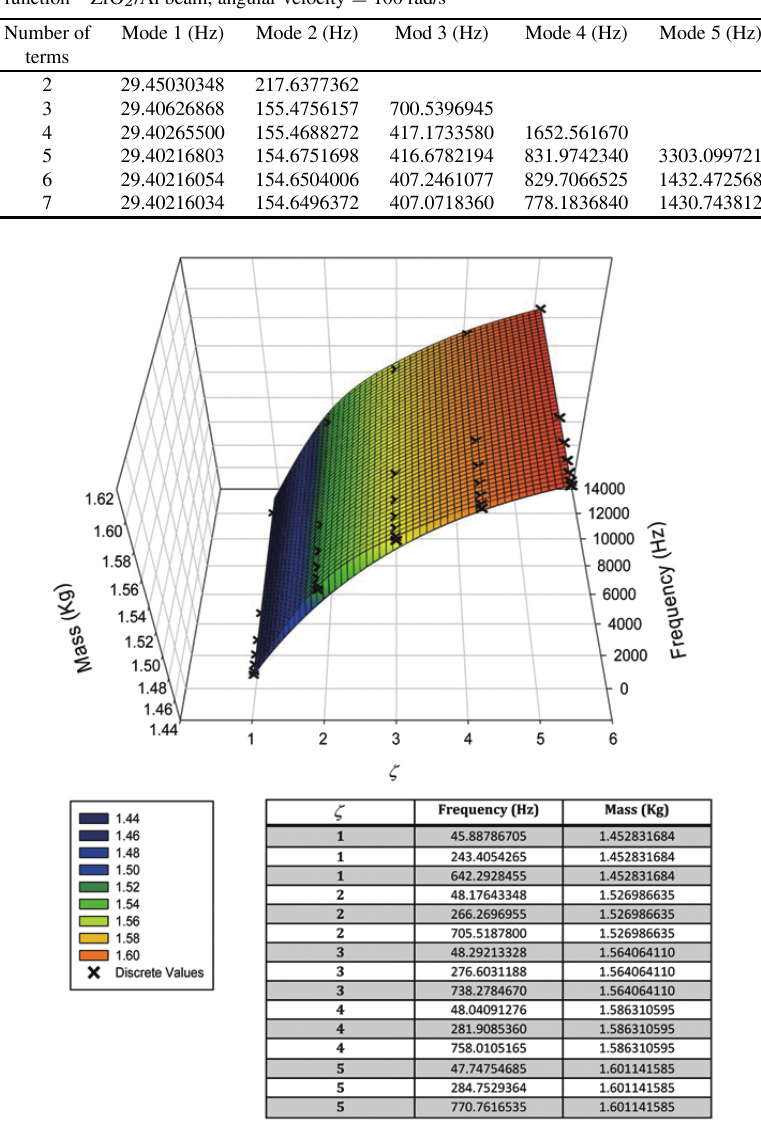
Fig. 2. Mass and frequency variation as a function of ζ for Al 2 O 3 –